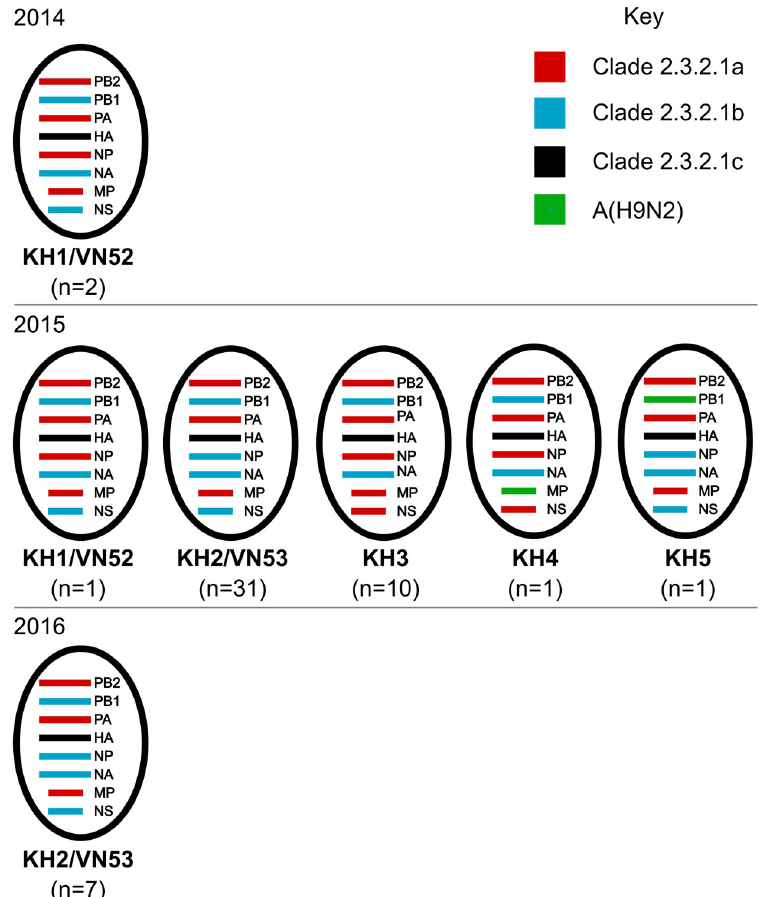
Fig 3. Genotypes of highly pathogenic A(H5N1) viruses detected in circulation in Cambodia from 2014 to 2016. Genomic segments are colour coded to show their possible ancestry. A(H5) clade 2.3.2.1a is shown in red, clade 2.3.2.1b in blue and clade 2.3.2.1c in black. Segments from A(H9N2) viruses are shown in green. Designated KH genotypes (KH1-KH6), any Vietnamese genotype equivalents (VN52, VN53) and the number of Cambodian isolates detected are shown below the associated genome